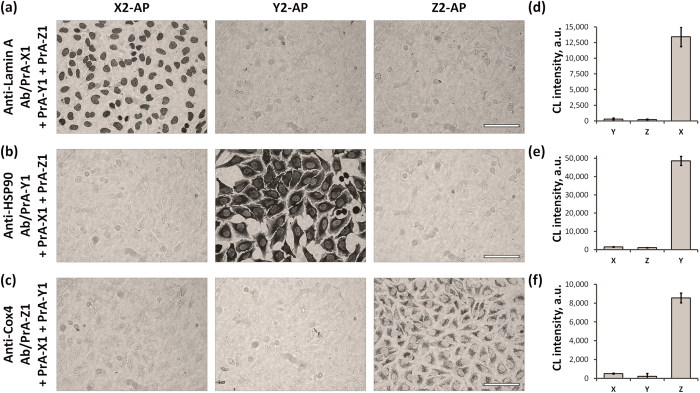
Assessment of cross-reactivity between Ab/PrA-ssDNA probes.Potential probe cross-reactivity was studied qualitatively with optical microscopy (a–c) and quantitatively in a multiplexed in-cell immunoassay format (d–f). Fixed HeLa cells were incubated with a mixture of one type of Ab/PrA-ssDNA probe and two competing free PrA-ssDNA conjugates: anti-Lamin A Ab/PrA-X1 probe was combined with PrA-Y1 and PrA-Z1 (a,d); anti-HSP90 Ab/PrA-Y1 with PrA-X1 and PrA-Z1 (b,e); anti-Cox4 Ab/PrA-Z1 with PrA-X1 and PrA-Y1 (c,f). For microscopy, single-target staining was performed on separate cell specimens by labeling with either X2-AP, Y2-AP, or Z2-AP probes and reacting with a precipitating chromogenic AP substrate (a–c). Images were converted to grayscale for clarity. Scale bar, 100 μm. For multiplexed quantitative analysis, cells were first labeled with all three reporters (a cocktail of X2-AP, Y2-AP, and Z2-AP) and then sequentially treated by displacement probes (X3, Y3, and Z3) to isolate AP fractions corresponding to each DNA sequence. AP concentration in isolated fractions was measured on a plate reader using chemiluminescent (CL) AP substrate (d–f). Average values (triplicate experiments normalized by cell number) with standard deviation are shown.